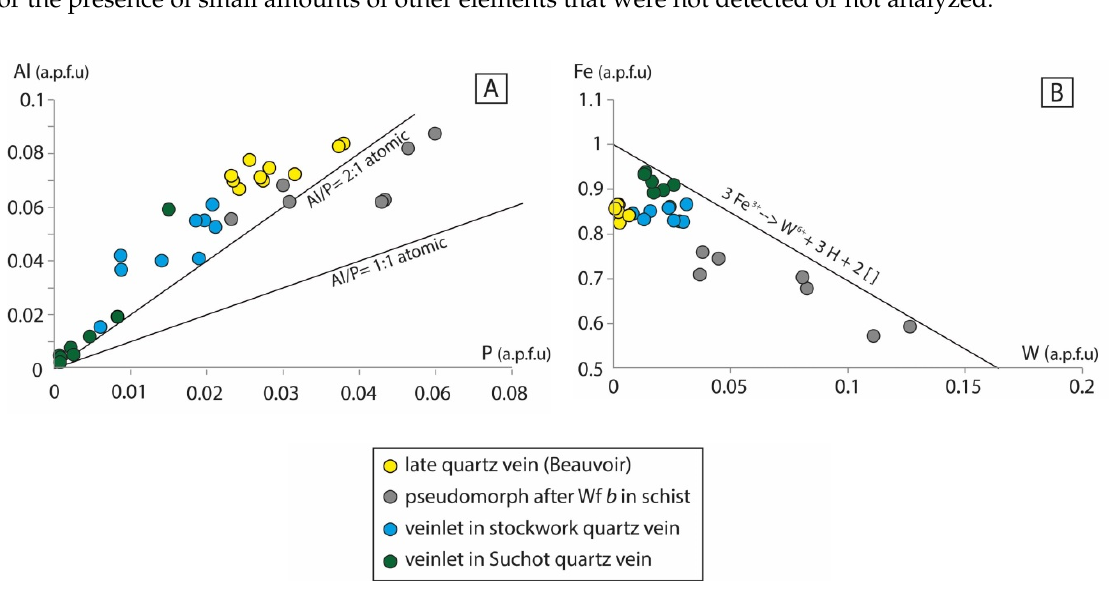
Figure 11. EPMA data for goethite; binary diagrams show positive correlations for Al and P ( A ), and negative correlations for Fe and W ( B ). Values are in atoms per formula units (a.p.f.u.) and the equation used for W substitution for Fe is that of [42].